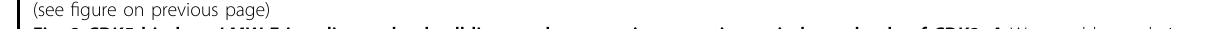
Fig. 2 CDK5 binds to LMW-E in salivary gland cell lines and transgenic tumor tissues independently of CDK2. A Western blot analysis showing LMW-E expression and other cell cycle markers in isogenic human salivary gland (HSG) clones. Lentivirus transduction was used to generate cells stably expressing either S protein-FLAG-Streptavidin binding protein (SFB) tagged LMW-E or CDK2 binding site mutated LMW-E R130A . B (Left panel) Isogenic HSG cell lines and HEK293 were subjected to immunoprecipitation (IP) with an anti- fl ag antibody using 1 mg of protein extracts followed by fl ag peptide elution and loading (20% of eluent) onto a 10% SDS-PAGE followed by mass spectrometry analysis. The bar graphs show the number of unique peptides of CDKs each protein bound to either LMW-E expressing clones A1 and A5 or LMW-E R130A expressing clones 9 and 10 and cyclin E full length and LMW-E overexpressing HEK-203 cells. (Right panel) Schematic of the SFB constructs used to generate stable isogenic HEK293 and HSG cell lines expressing either full-length cyclin E (cyclin E-FL), LWM-E or CDK2 binding site mutated LMW-E R130A constructs. C IP/ western blot analysis in LMW-E expressing clones A1 and A5 and LMW-E R130A expressing clones #9 and #10. Brie fl y, 400 µg protein lysates from each cell line were subjected to IP with either anti-IgG or anti-cyclin E and the indicated cyclin E bound proteins were assessed by western blot analysis. Input lanes were loaded with 40 µg of whole-cell lysates for each cell line. Pulldown lanes labeled IgG lanes indicate pulldown with anti-IgG and lanes labeled cyclin E indicate pulldown with anti-cyclin E. D Radiographic fi lm showing the phosphorylation of the substrates GST-Rb and HH1 following IP with cyclin E, using 400 µg protein extracts of the indicated cell lines. E Quantitation of the bands from (D). The bar graph is the quanti fi cation of the mean cyclin E associated kinase activity, measured as counts per million (cpm) radioactivity units, representative of three independent kinase assay experiments. p Values (** p < 0.01, *** p < 0.001, ******** p < 0.0001) were calculated using the unpaired t-test with Welch ’ s correction. F Western blots analysis indicating unchanged expression of CDK5 in tumors from derived from LMW; p53 + / − ; CDK2 + / + mice ( N = 3) and LMW; p53 + / − ; CDK2 − / − mice ( N = 6). The bottom panel depicts the ImageJ quanti fi cation (and comparison) of CDK5 between the CDK2 + / + ( N = 3) and CDK2 − / − ( N = 6) tumors. G Immunoprecipitation with anti-FLAG followed by western blot analysis to assess the binding of CDK5 and CDK2 to LMW-E in salivary gland tumors from LMW-E; p53 + / − ; CDK2 − / − ( N = 3) and LMW-E; p53 + / − ; CDK2 + / + ( N = 6) mice. The bottom panel depicts the ImageJ quanti fi cation (and comparison) of cyclin E and CDK5 IP/western bands between the CDK2 + / + ( N = 3) and CDK2 − / − ( N = 6)